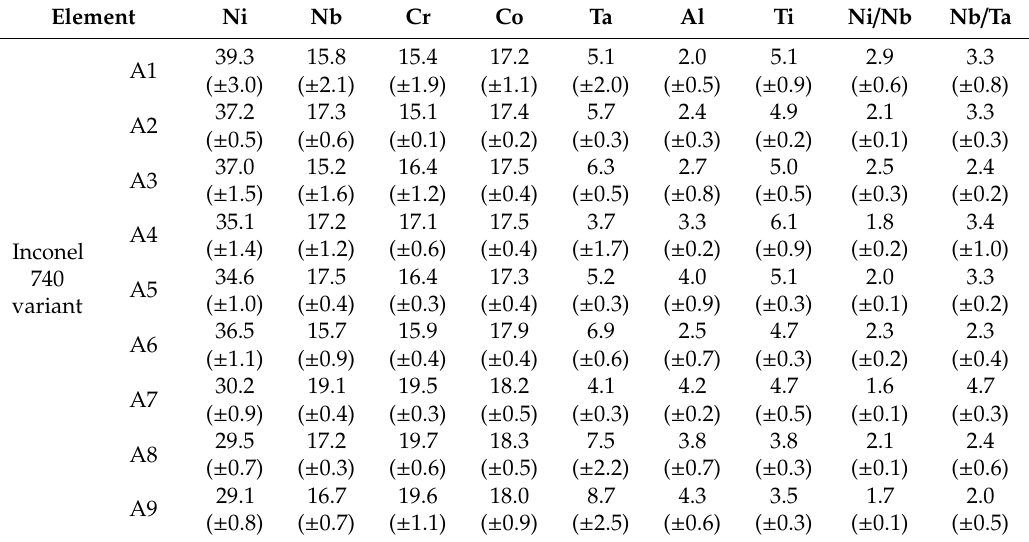
Table 5. Chemical composition of Nb-rich precipitates in castings, at%.